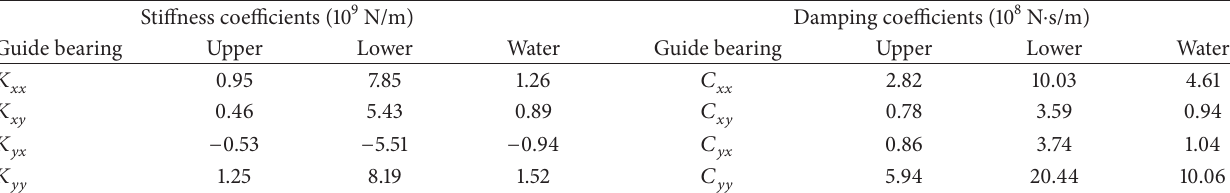
Table 2: Identification results of dynamic characteristic